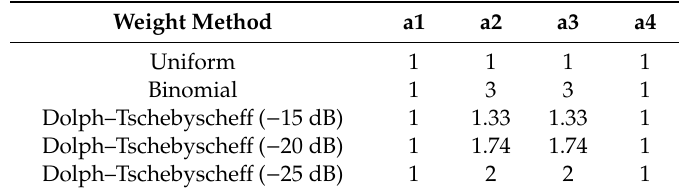
Table 2. Estimated amplitude distribution.